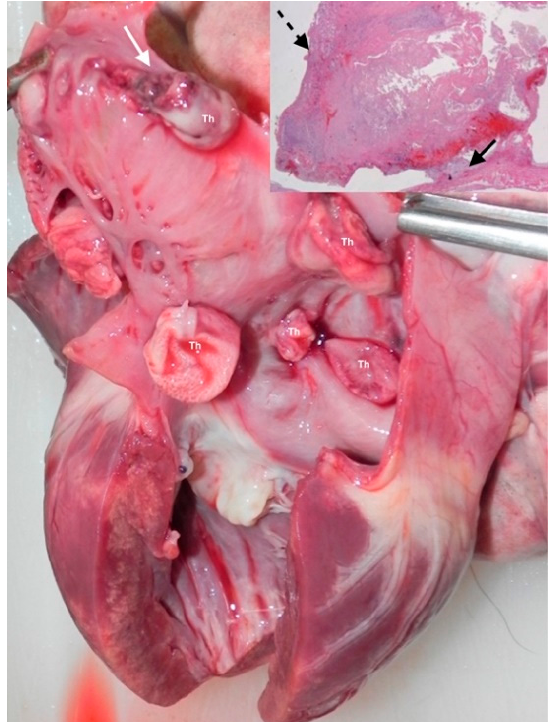
Figure 3. Necroscopy imaging. Several, up to 1 cm, pink, pedunculated masses (thrombi) adherent to the mural endocardium of the interatrial septum and left auricle. Note the hemorrhages around the base in the upper thrombus (white arrow). Mitral septal (anterior) leaflet is thickened and distorted, and in the myocardium multifocal to coalescing whitish areas (necrosis with calcifications). Insert: pedunculated thrombus (dashed arrow) attached to the endocardial surface of the auricle (black arrow); Hematoxylin and eosin, low magnification. Th, thrombus.